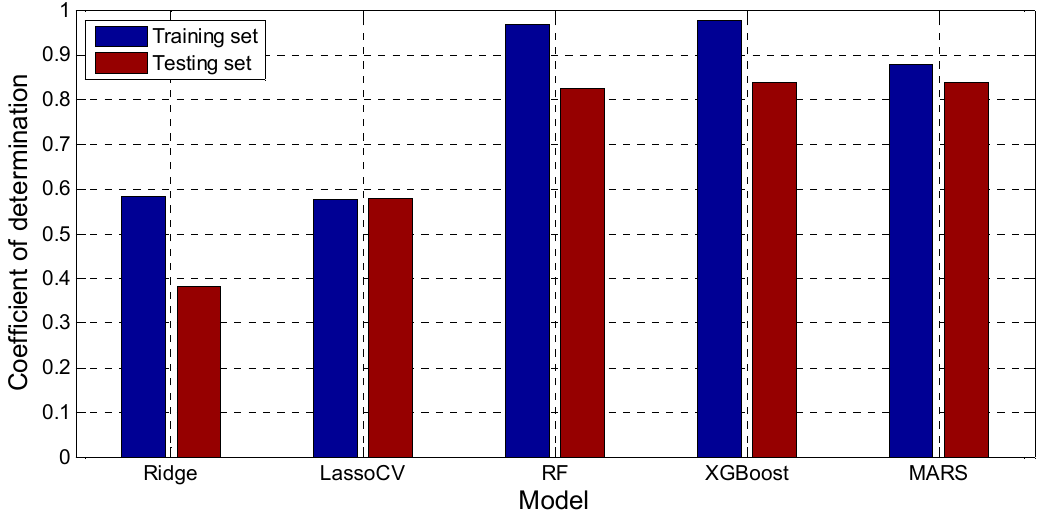
Figure 34. R2 scores of the Ridge, Lasso, RF, XGBoost, and MARS model.